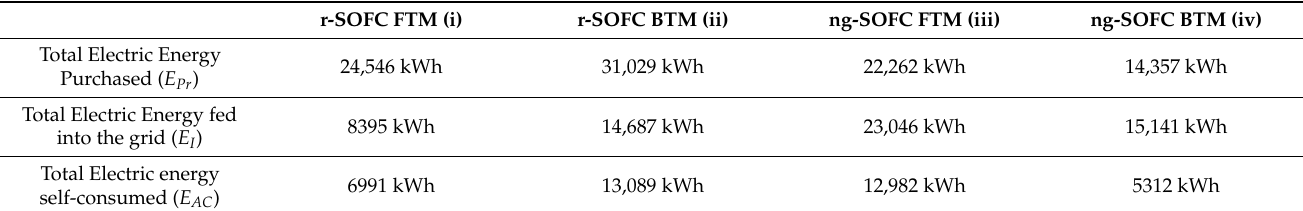
Table 5. Energy flows related to self-consumers group